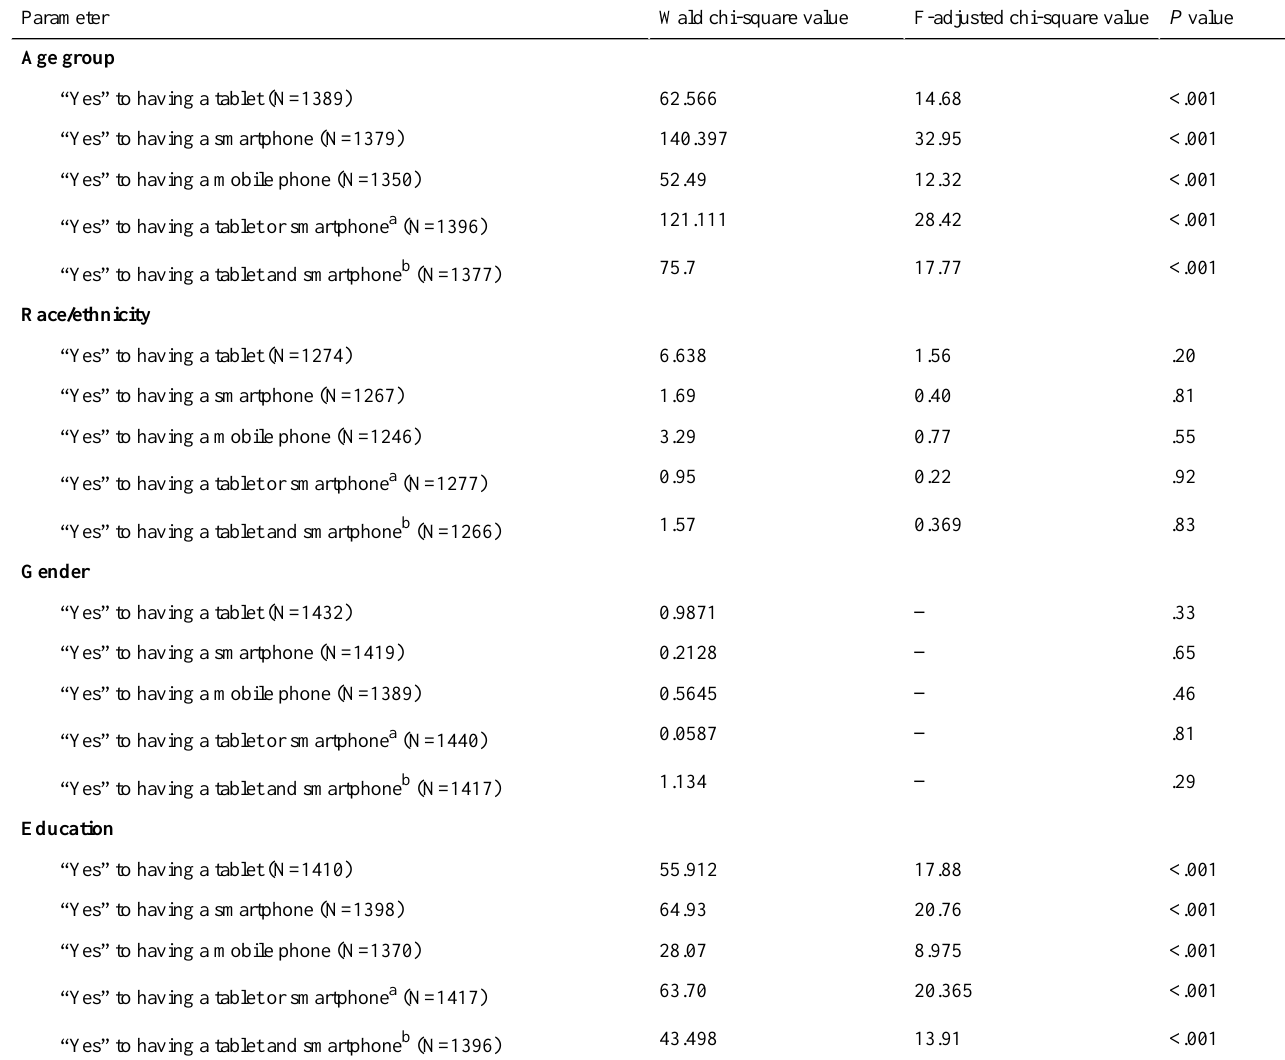
Table 3. Statistical results of device ownership and use among patients with hypertension. Sample sizes reflect the number of participants with nonmissing values for device questions and